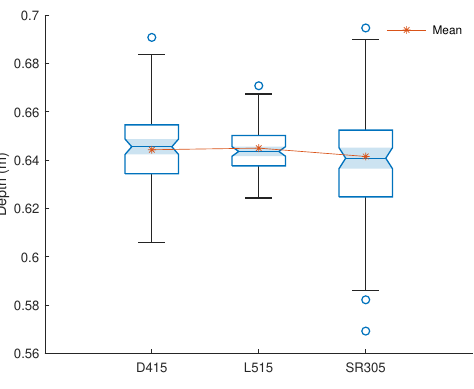
Figure 10. Normal Distributions - Wall test